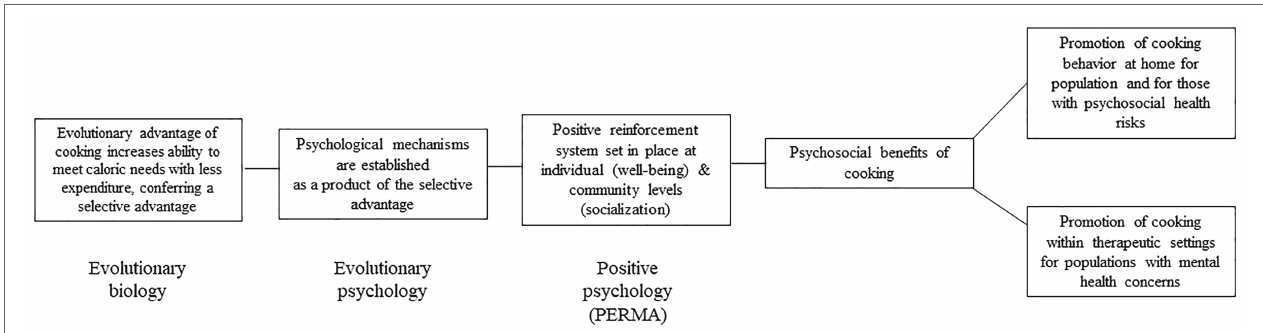
FIGURE 1 | Concept model of psychosocial benefits of cooking showing multi-theoretical basis and proposed applications for overall health, including both mental and physical